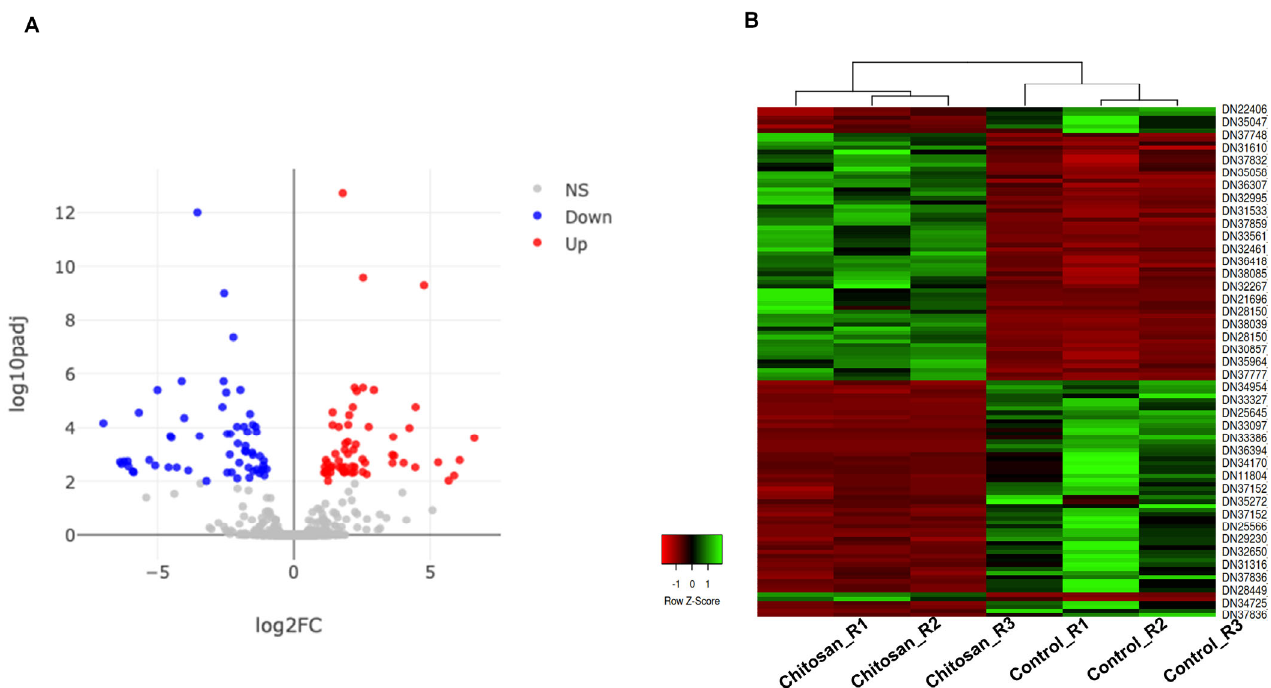
Figure 3. Visualization of significant differentially expressed genes (DEGs) in response to chitosan treatment. ( A ) The volcano plot displays 121 significant DEGs, which were divided into 60 down- regulated (blue dots) and 61 up-regulated (red dots). Gray dots indicate the remaining genes in which expression was not significantly changed. The representations are as follows: x-axis, logFC; y-axis, -log10 of the p-value. ( B ) The heat map shows the hierarchical clustering of 121 DEGs according to samples and genes. Up ‐ regulated and down ‐ regulated genes were shown in red and green bars, respectively.